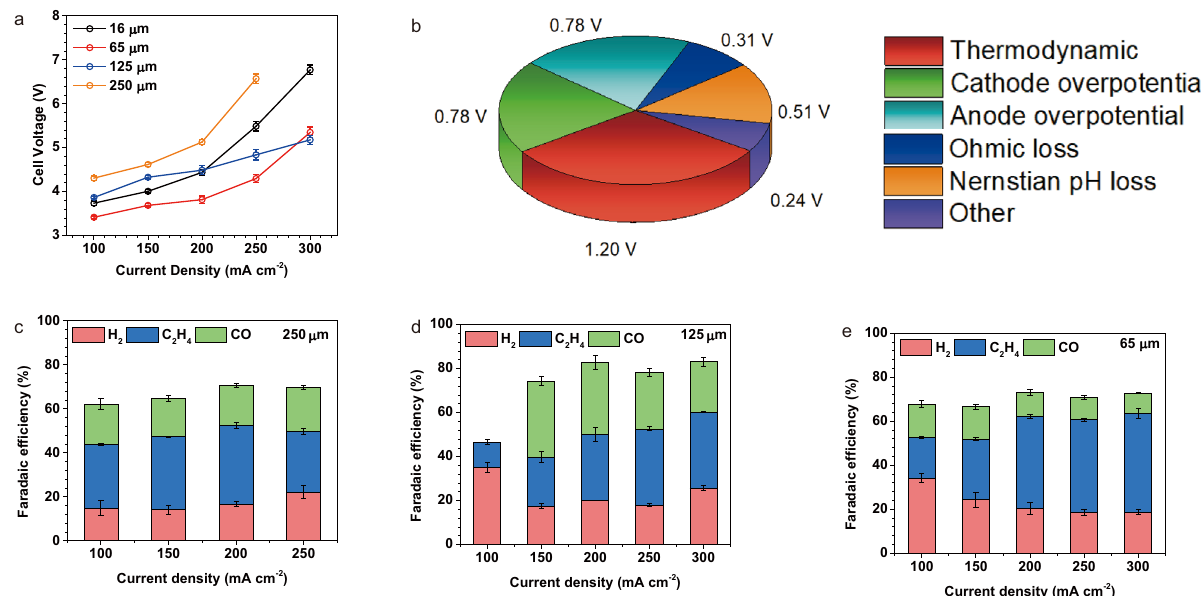
Fig. 3 Investigations on the CO 2 RR performance of the SC-BPMEA using catholyte thicknesses of 250, 125, 65, and 16 μ m. All the results are collected at 35 °C with a CO 2 fl ow rate of 10 sccm cm − 2 (normalized by the geometric area of the cathode), a catholyte of 0.5 M K 2 SO 4 , and an anolyte of 0.1 M KHCO 3 . a The dependence of cell voltages on current density. b Distribution of voltage losses measured in the SC-BPMEA with 65 μ m thick catholyte operating at 200 mA cm − 2 (cell voltage = 3.82 V). The breakdown of the voltage is explained in SI7 of the Supplementary Information. The dependence of the CO 2 RR gas products FE on the current density for the SC-BPMEAs with the catholyte thickness of 250 ( c ), 125 ( d ), and 65 μ m ( e ). The FE result for 16 μ m is shown in Supplementary Fig. 12. The error bars represent the standard deviation of three 300 mA cm − 2 (Fig. 2c). In conventional AEMEAs, the anionic